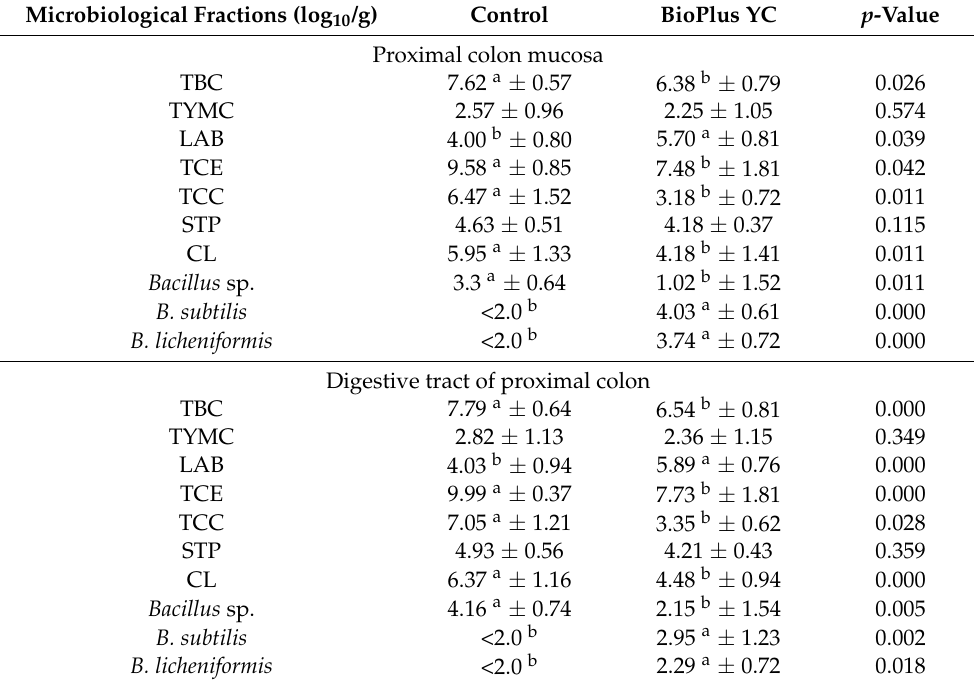
Table 4. Colon microbiota composition.